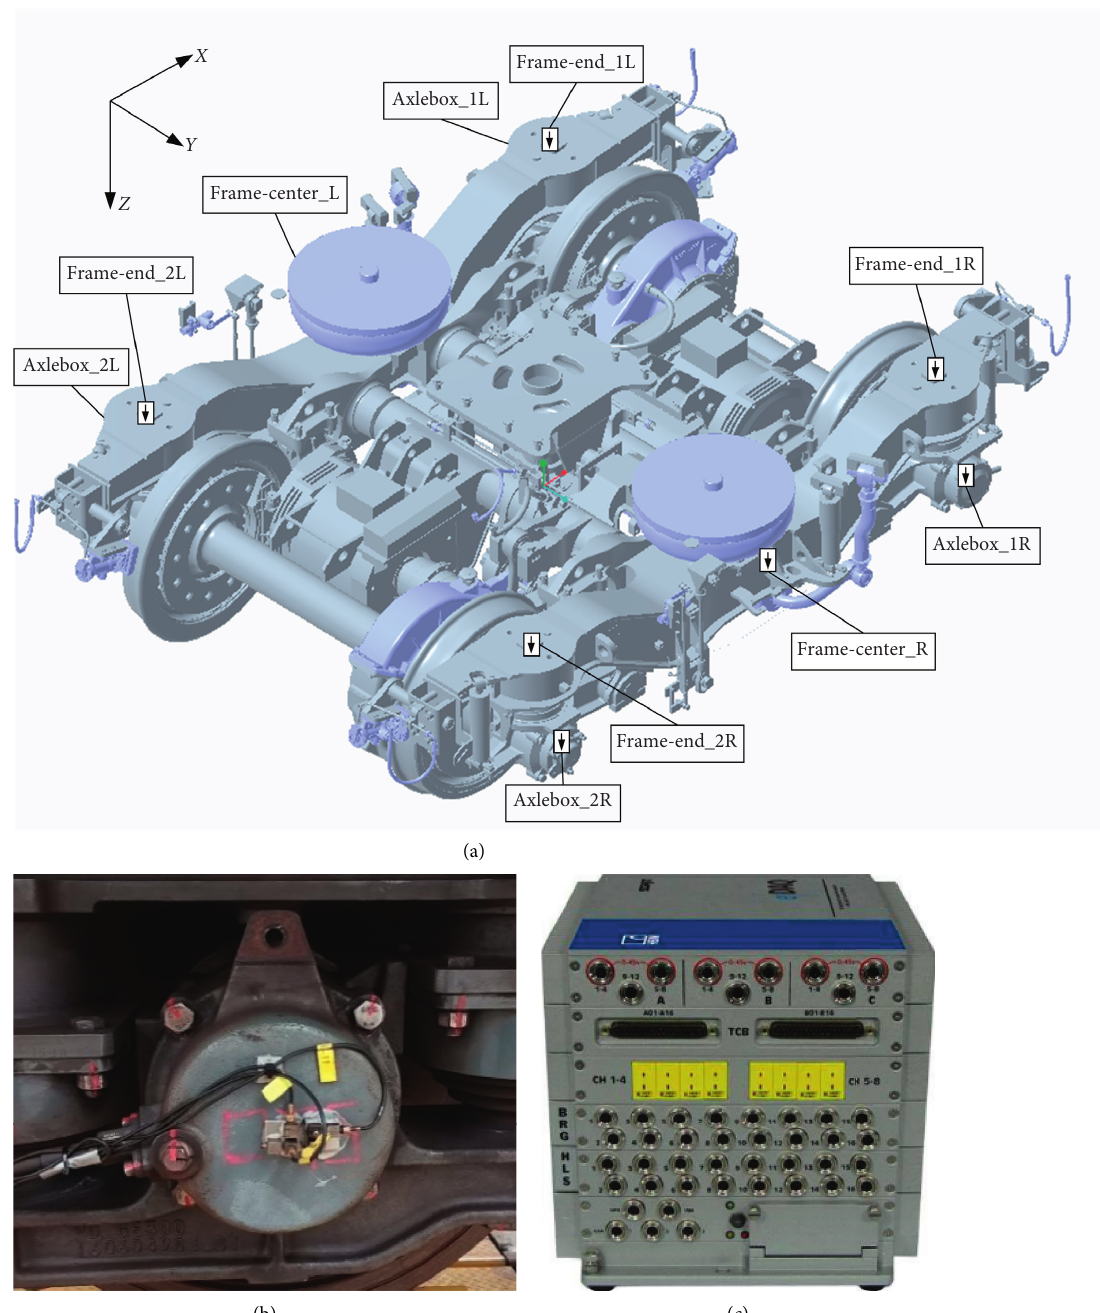
Figure 1: Acceleration sensor measurement points for dynamic test on metro bogie. (a) Measurement points of acceleration sensor on bogie. (b) Acceleration sensor on axlebox. (c) Data